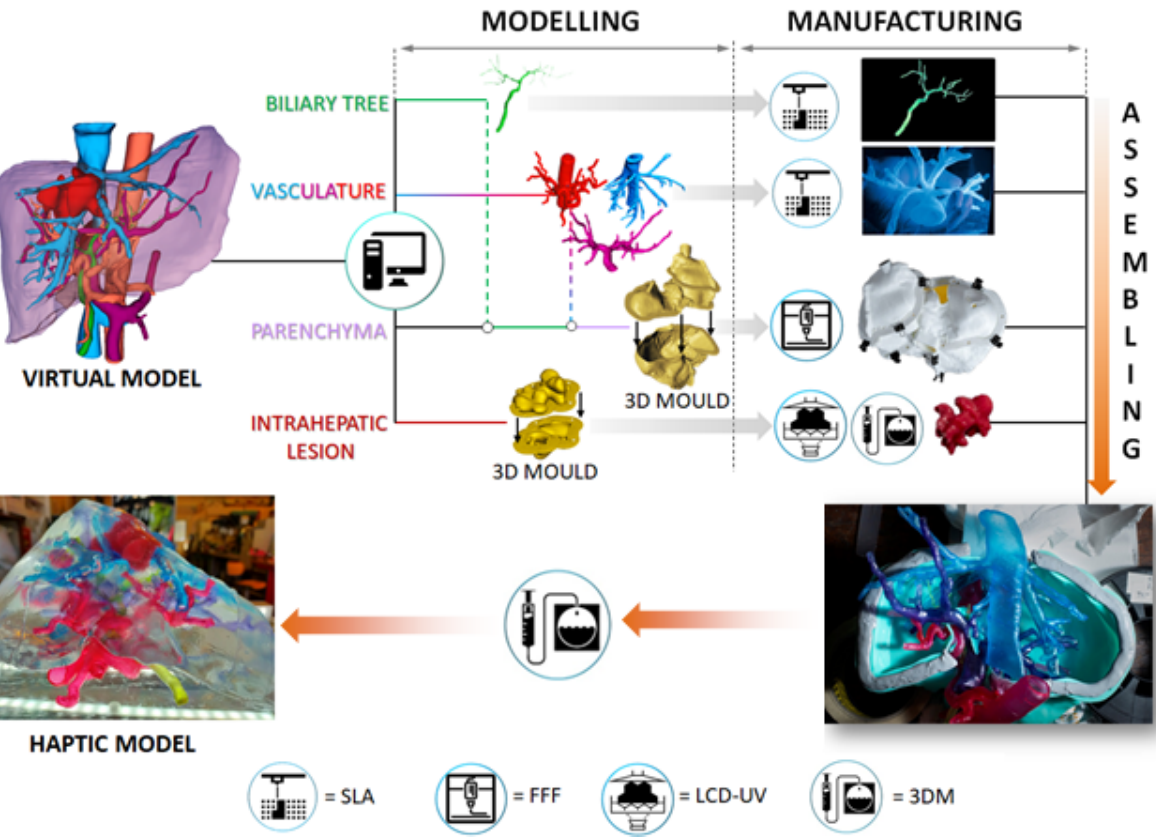
Figure 2. Schematic of the workflow adopted for the fabrication of the haptic liver models. Legend: SLA = stereolithography; FFF = fused filament fabrication; LCD-UV = liquid crystal display based VAT photopolymerisation; 3DM = 3D moulding.